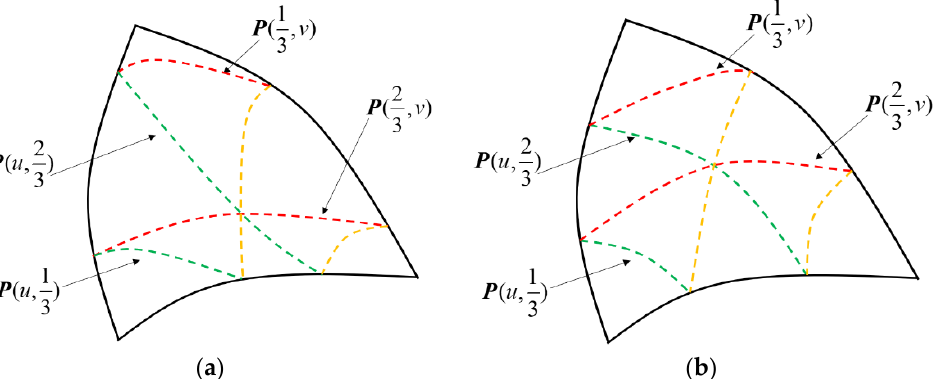
Figure 1. Different parameterizations have different iso-parametric curve distributions: ( a ) poor and ( b ) good parameterization.